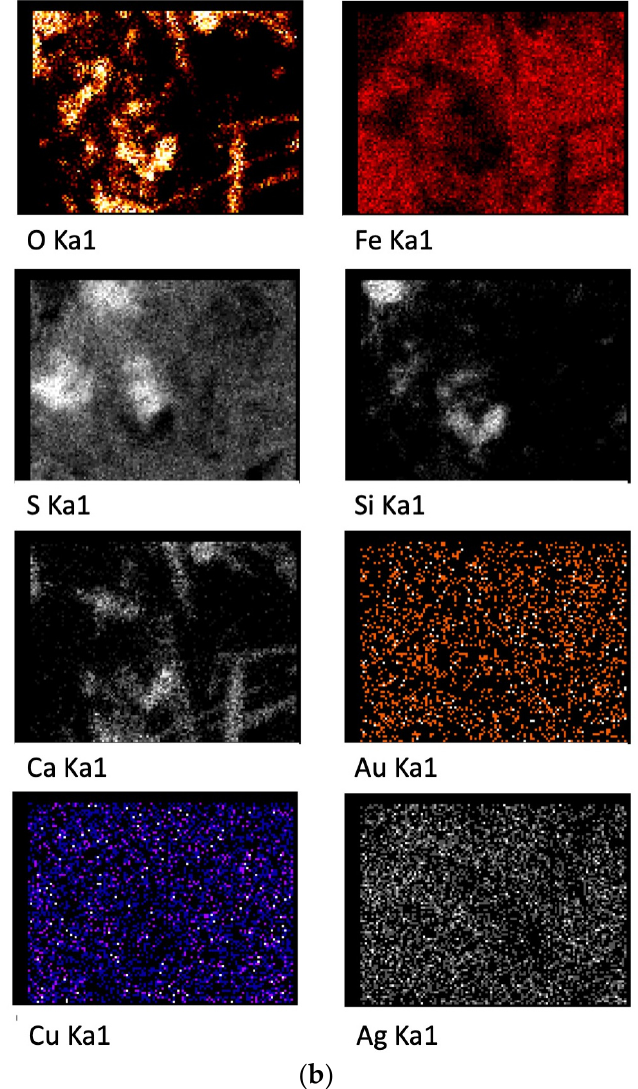
Figure 8. ( a ). Punctual microanalysis of particles by SEM–EDS micrograph showing a pyrite particle at 10 μ m, and X ‐ ray diffraction pattern of oxidized gold concentrate. The spectrum indicates the presence of pyrite, quartz, and magnetite. ( b ) X ‐ ray mapping of the pyrite particles tests by SEM ‐